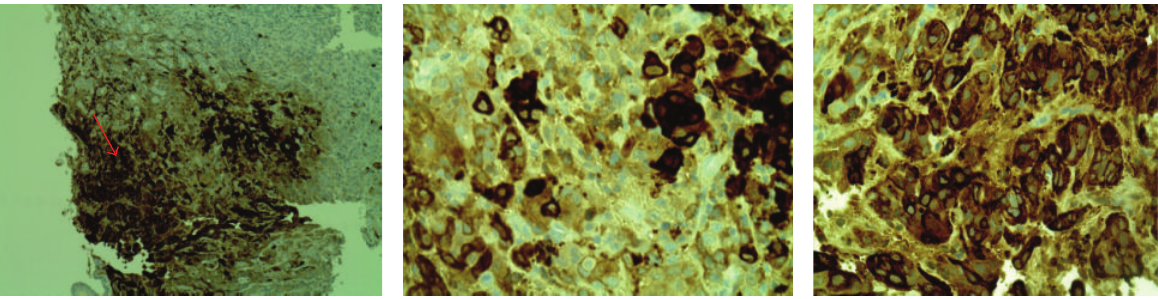
Figure 5: Histopathology of undifferentiated gastric tumor cells stained positive for b-HCG.